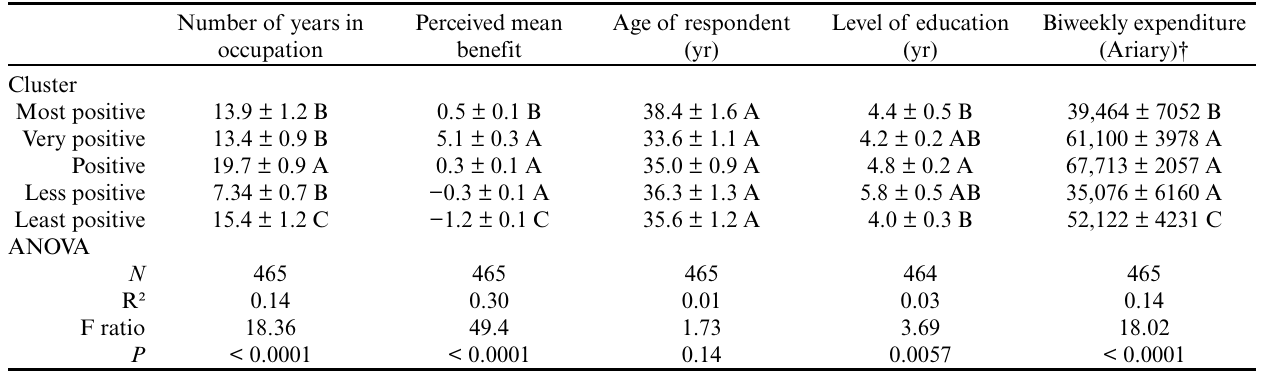
Table 5. Summary of key descriptions (mean ± SE) of the respondents in the three clusters of management preferences and one-way ANOVA test of significance. The material lifestyle metric is a multivariate principal component analysis scaling based on ownership of various household items; positive values indicate greater material assets and vice versa. Different uppercase letters indicate significant differences among clusters based on post-hoc Tukey multiple comparisons.